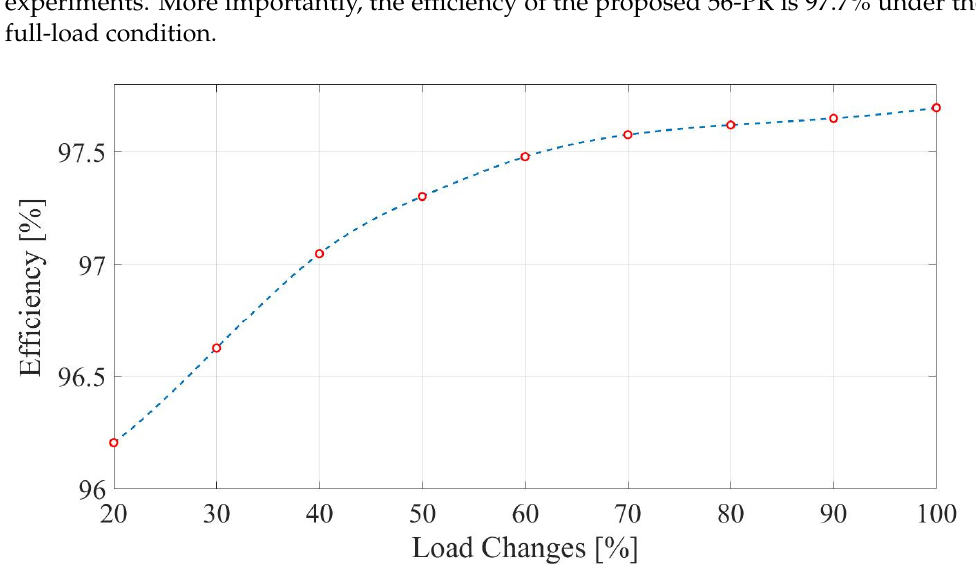
Figure 5. The efficiency versus output power for the proposed 56-PR.